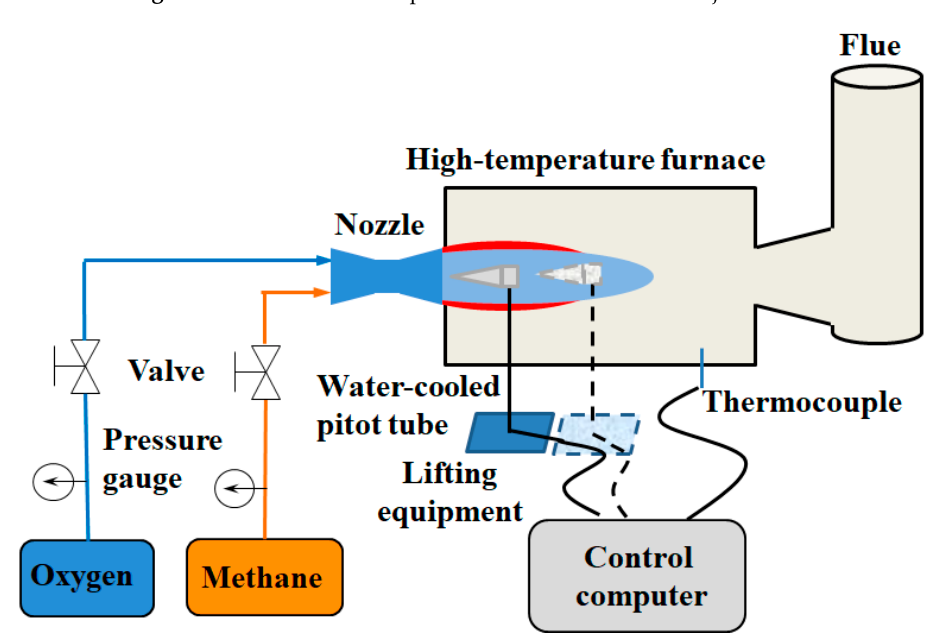
Figure 2. Schematic of the experimental apparatus.